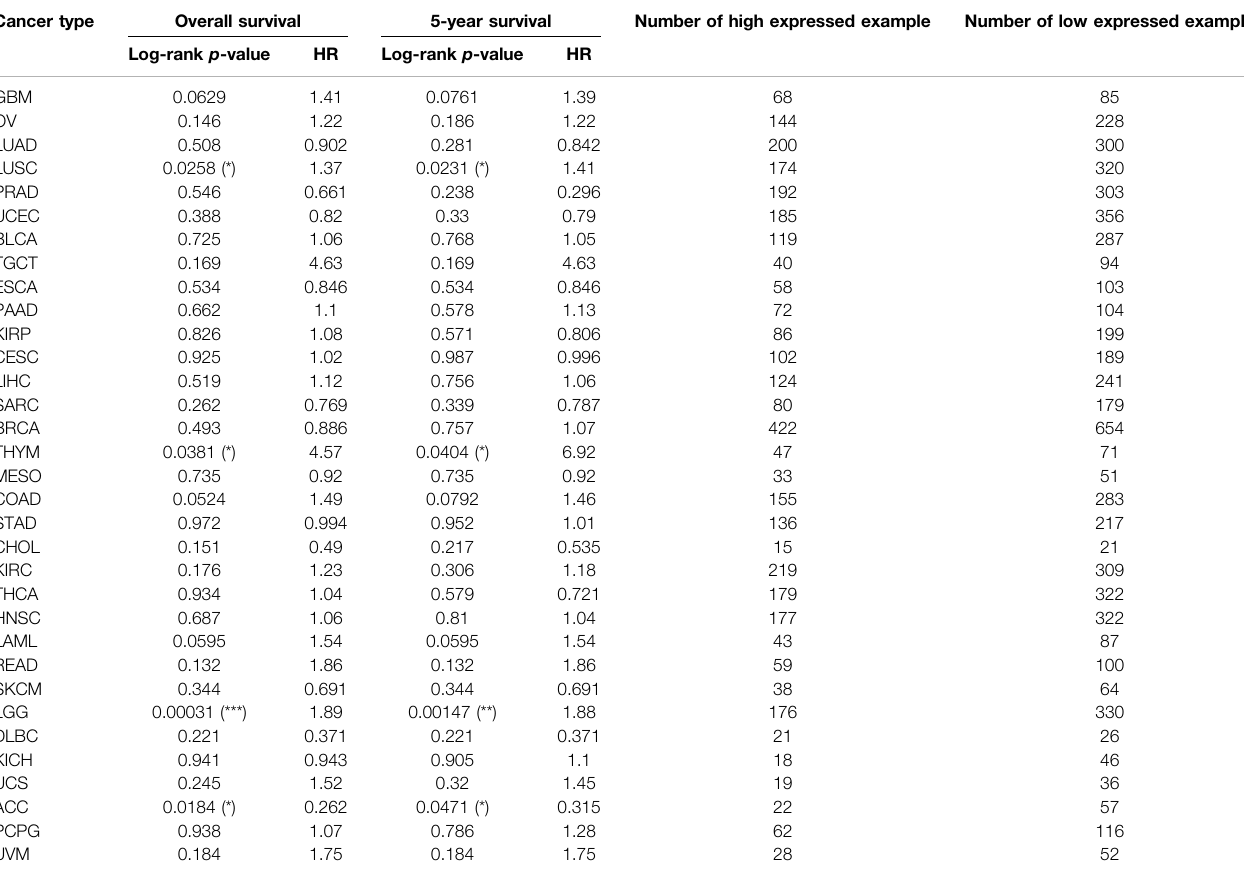
TABLE 1 | Overall survival analysis of TCGA tumors by DriverDBv3. Cancer type Overall